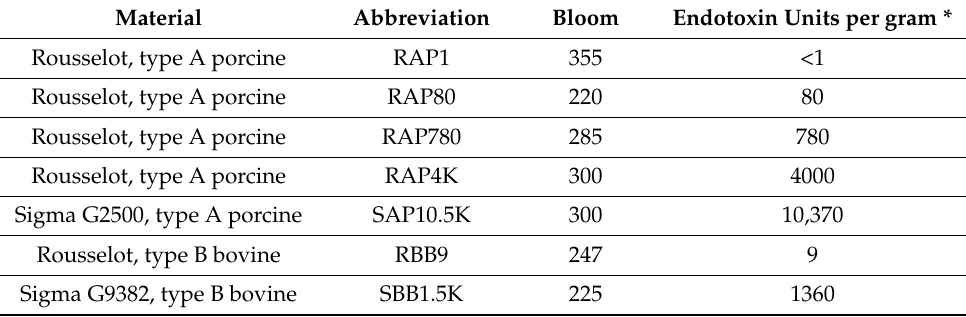
Table 1. Properties of gelatin samples used in this study. * The endotoxin units per gram values were provided by the supplier and were measured using the ENDONEXT™ EndoZyme ®